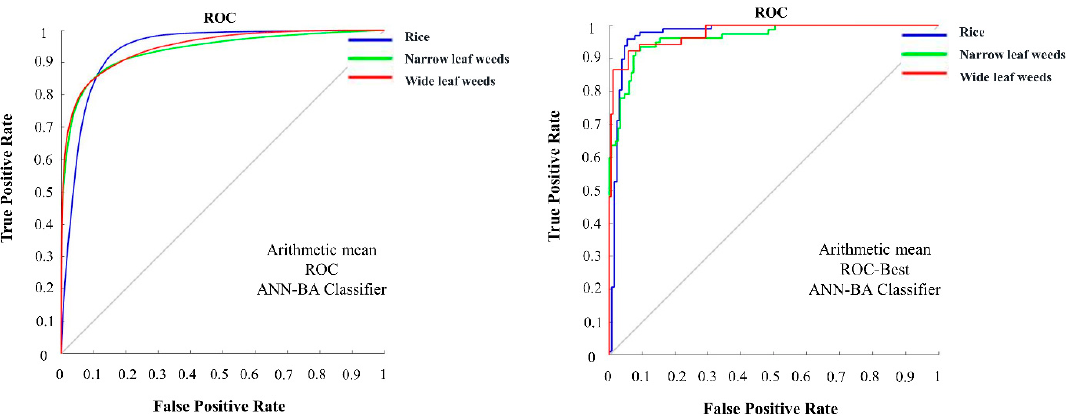
Figure 4. Performance evaluation of the ANN-BA classifier on the test dataset in the four categories (right, left, geometric mean, and arithmetic mean) based on the ROC and ROC-best curves related to the three classes (rice, narrow-leaf weed, and wide-leaf weed).